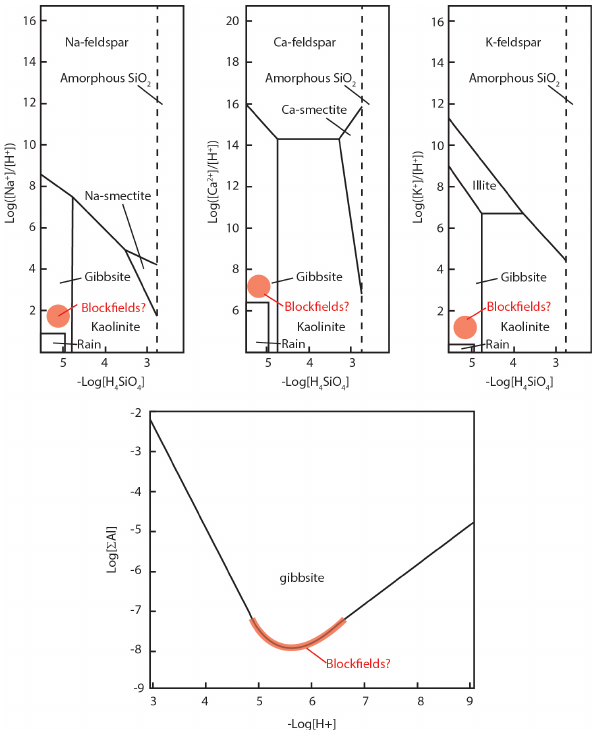
Figure 9. Thermodynamic stability relations between feldspars, secondary minerals, and weathering solutions (top panels) and the relationship between gibbsite solubility and the pH of regolith water (bottom panel). Relatively low Na + Ca 2 + , and K + abundances and high H + abundances favour secondary mineral formation. Solute concentrations are usually most favourable to kaolinite precipita- tion, but gibbsite forms where regolith waters have very dilute sil- ica concentrations, similar to rainwater (adapted from Stumm and Morgan, 1981, p. 547, and Nesbitt and Young, 1984, p. 1524, with permission of Wiley and Elsevier, respectively). Gibbsite is least soluble where pH is 5–6, and its solubility increases as pH is el- evated or lowered from this value (adapted from Wesolowski and Palmer, 1994). It is expected that these key conditions of low silica concentration and slight acidity occur in Arctic–alpine blockfields, which favours gibbsite precipitation in these